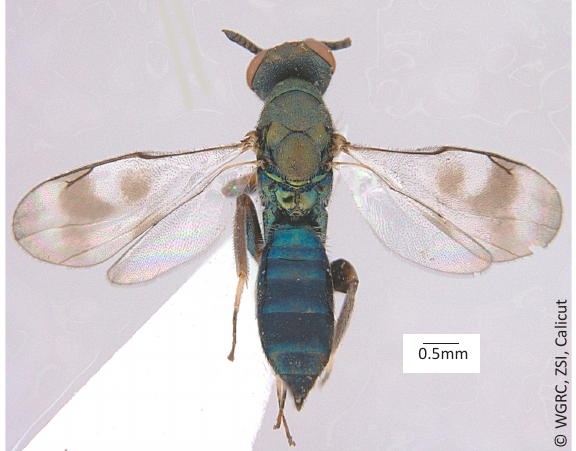
Image 1. Cleonymus kamijoi sp. nov. Body in dorsal view.